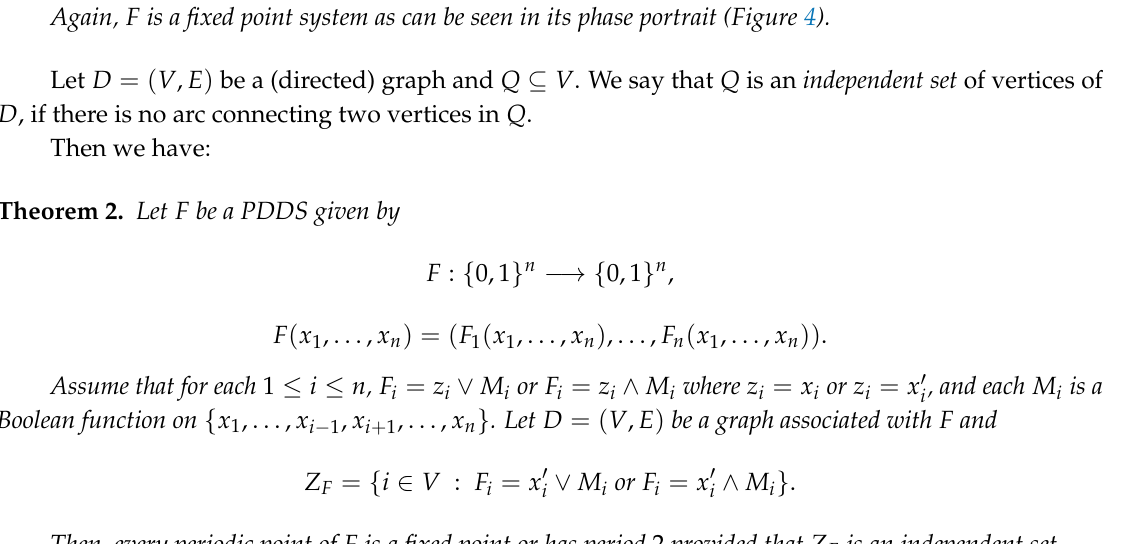
Figure 1. Graph associated with F ( x 1 , x 2 , x 3 ) = ( x 1 ∧ ( x 2 ∨ x 3 ) , x 2 ∧ ( x (cid:48)